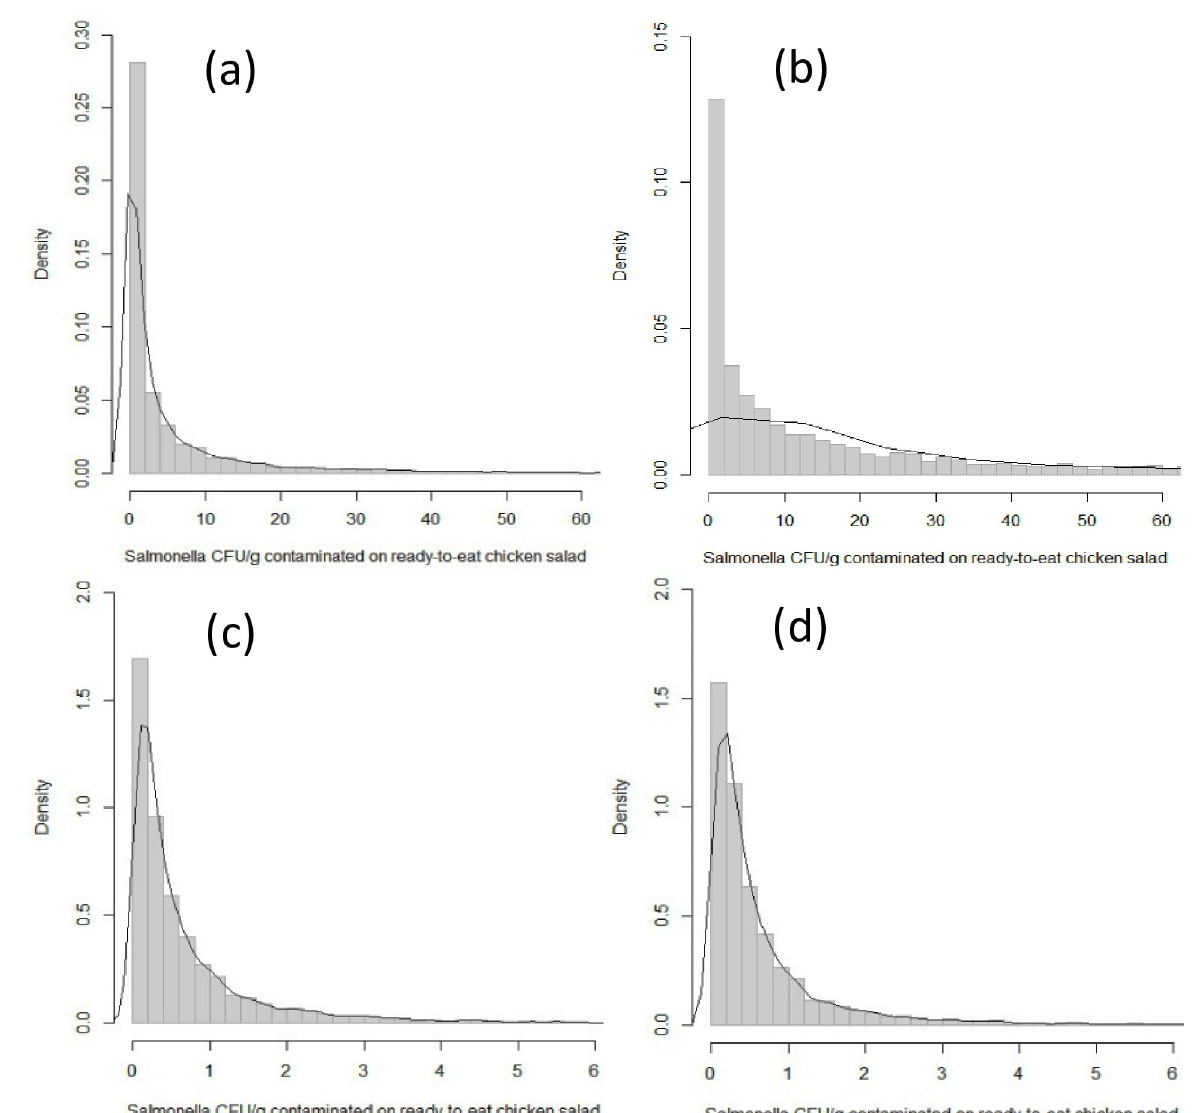
Fig 3. Salmonella concentration (CFU/g) on contaminated RTE chicken salad in Scenario 1 � (a), Scenario 1 �� (b), Scenario 2 (c) and Scenario 3 (d) based on the experiment values simulated 5000 times. � Scenario 1 had only values below the initial concentration (10 CFU/g); �� worst- case Scenario 1 included four MPN/g values (two 110 CFU/g and two 15 CFU/g), which exceeded the initial concentration (10